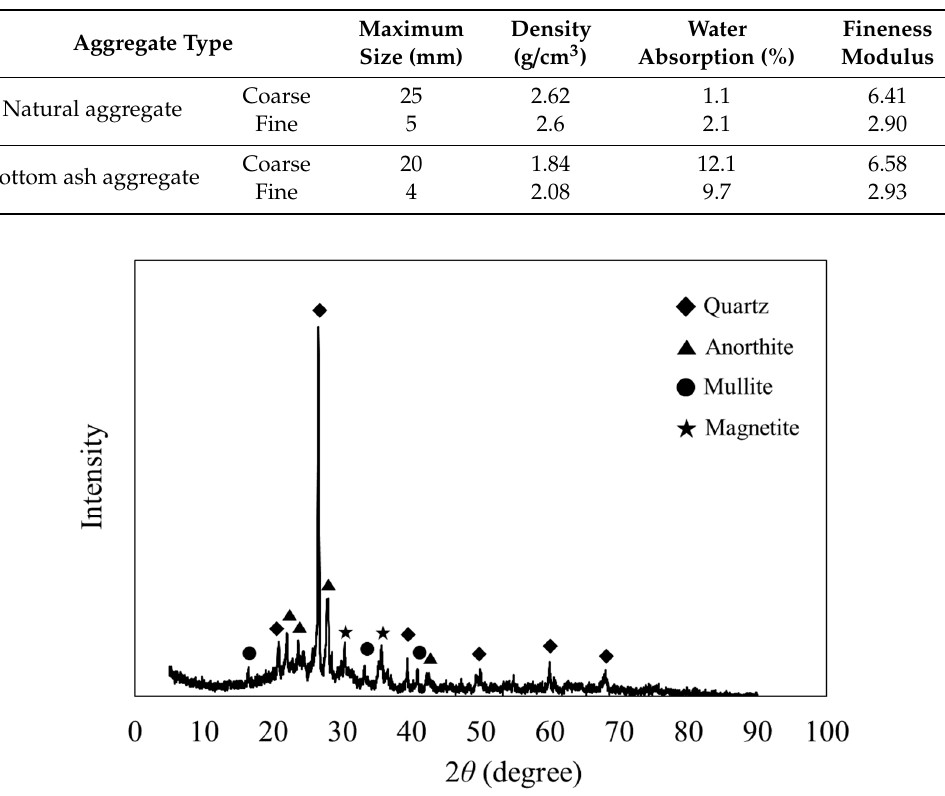
Table 2. Physical properties of aggregates used.